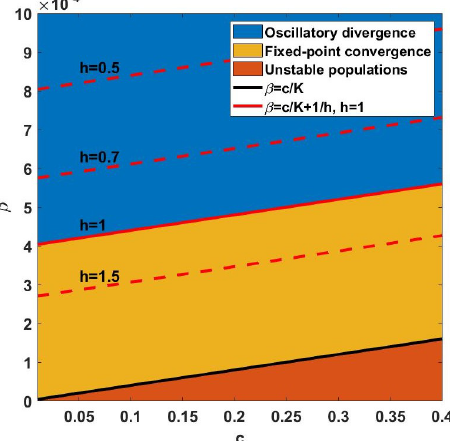
Figure 4. The fixed-point convergence region as a function of β and c for the discrete Ricker-type model and discrete Lotka-Volterra model where β = αγ , K = 2500 and r = 0.5. The fixed-point + 1 convergence region is bounded by β = c and β = c , ∀ h > 0. For h = 1, the stability regions are K K h + 1 coloured, and the upper and lower boundaries of the fixed-point region are plotted for β = c K and β = c , as displayed in solid red and black lines, respectively. The upper boundary of fixed-point K region moves upward with decreasing step size, marked as red dashed lines. Note that the lower boundary of the fixed-point convergence region is valid for any h .